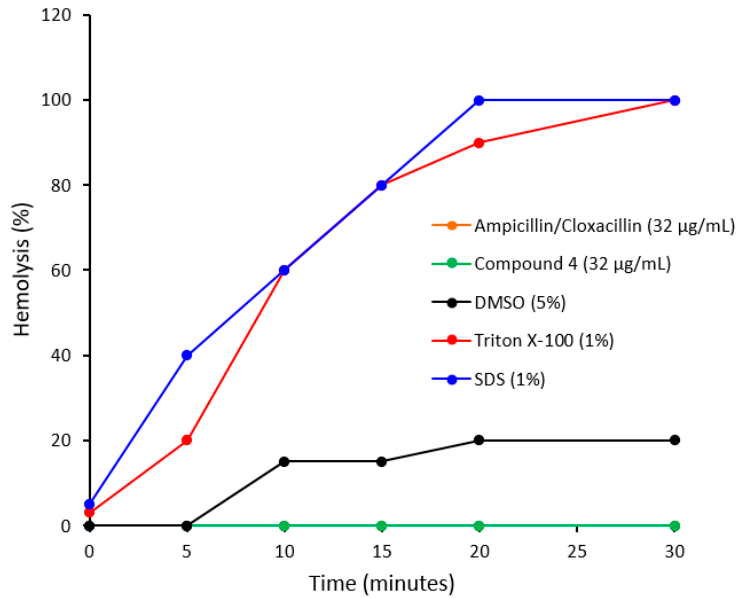
Figure 9. Comparison of hemolysis by compound 4 (green curve) and ampicillin/cloxacillin (orange curve overlapped by the green curve), Table